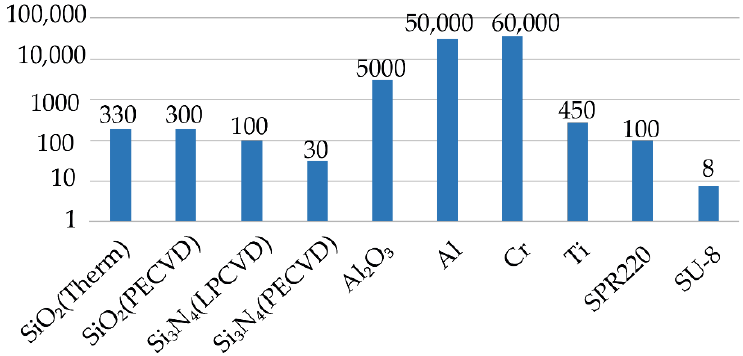
Figure 2. Basic protective masks for the Bosch process and their selectivity.